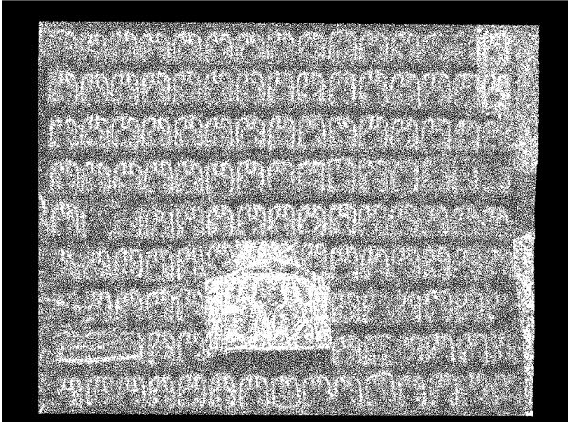
Figure 3. Point cloud data on the east side of the south wall of the Cave 18